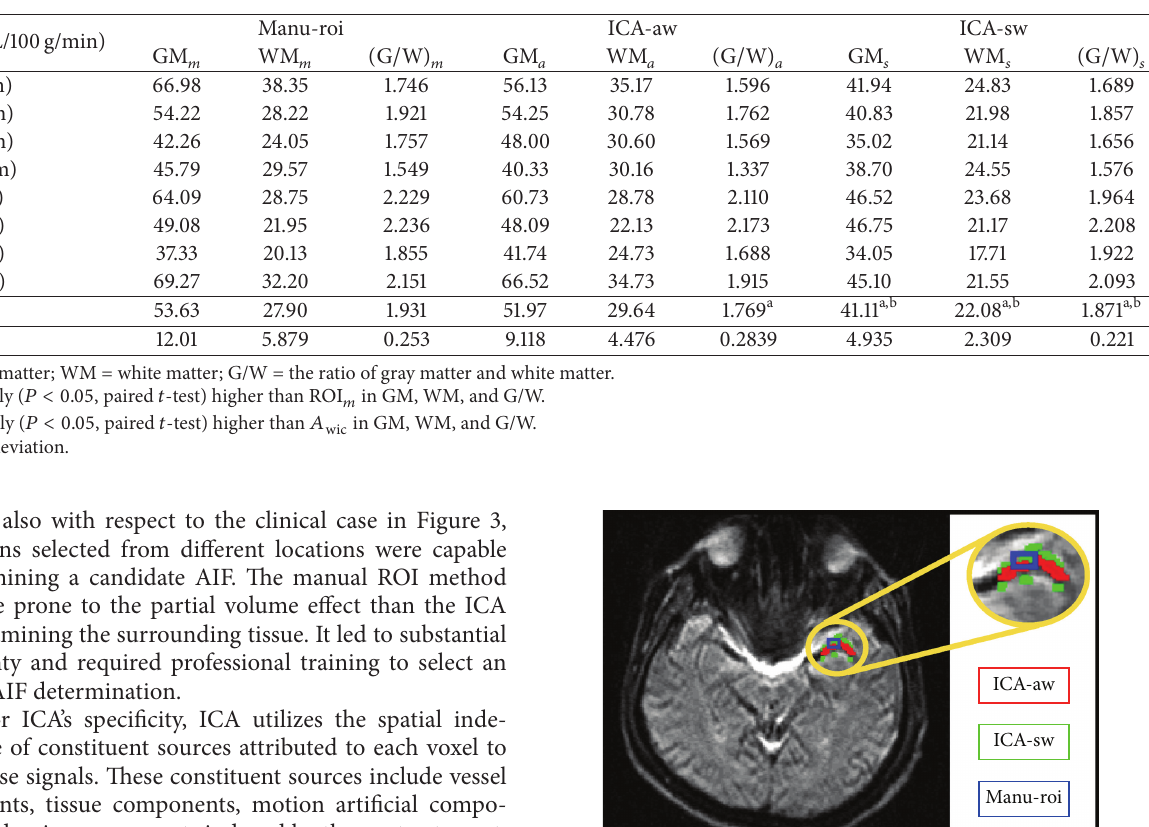
Table 2: rCBFs are calculated by the AIFs determined by the manual ROI (Manu-roi) and ICA-based ROI (weighted-ICA) method in gray and white matter regions. The paired 𝑡 -test is employed to test the difference between the manual and ICA-based method in the artery (GM 𝑎 and WM 𝑎 ) and surrounding tissue (GM 𝑠 and WM 𝑠 ) and between the artery and surrounding tissue in the ICA-based method in gray and white matter regions.